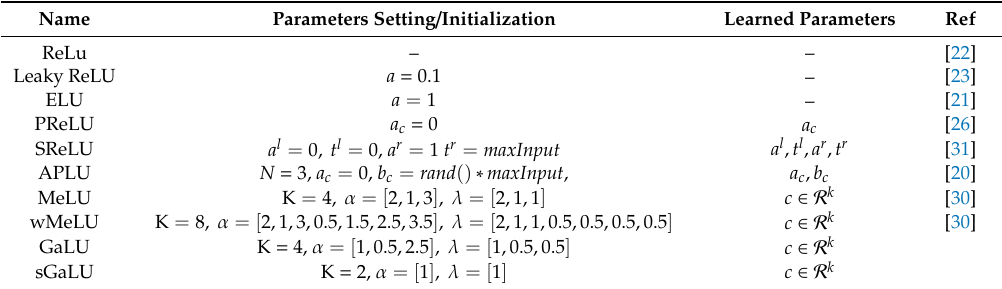
Table 1. Summary of the activation functions evaluated in this work: name, parameter settings or initialization (if they are learned), learned parameters, and